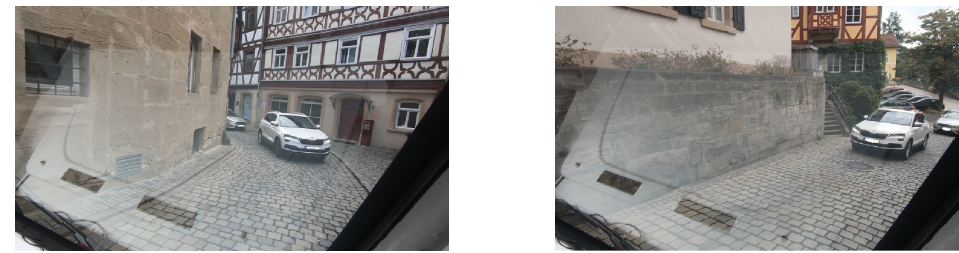
Figure 2. Slow moving traffic behind the automatic shuttle